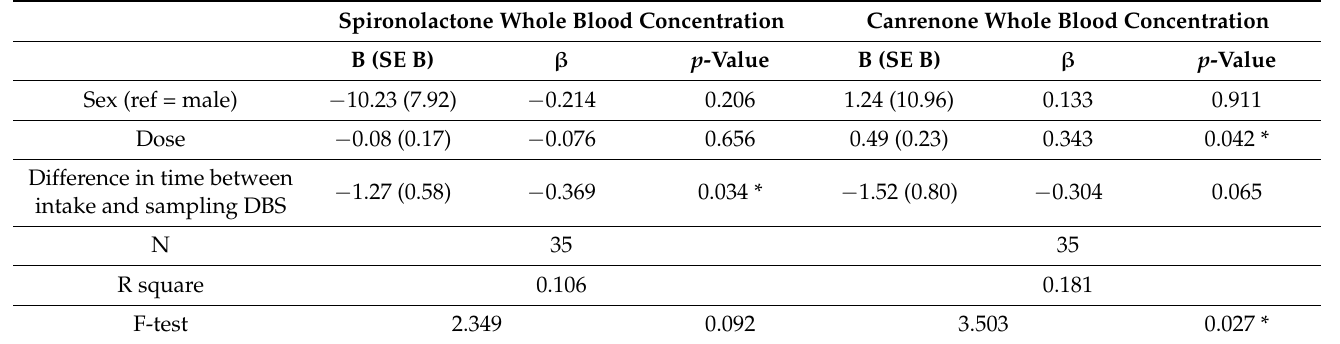
Table 3. Linear regression analysis on the influence of covariates on spironolactone and canrenone concentrations.